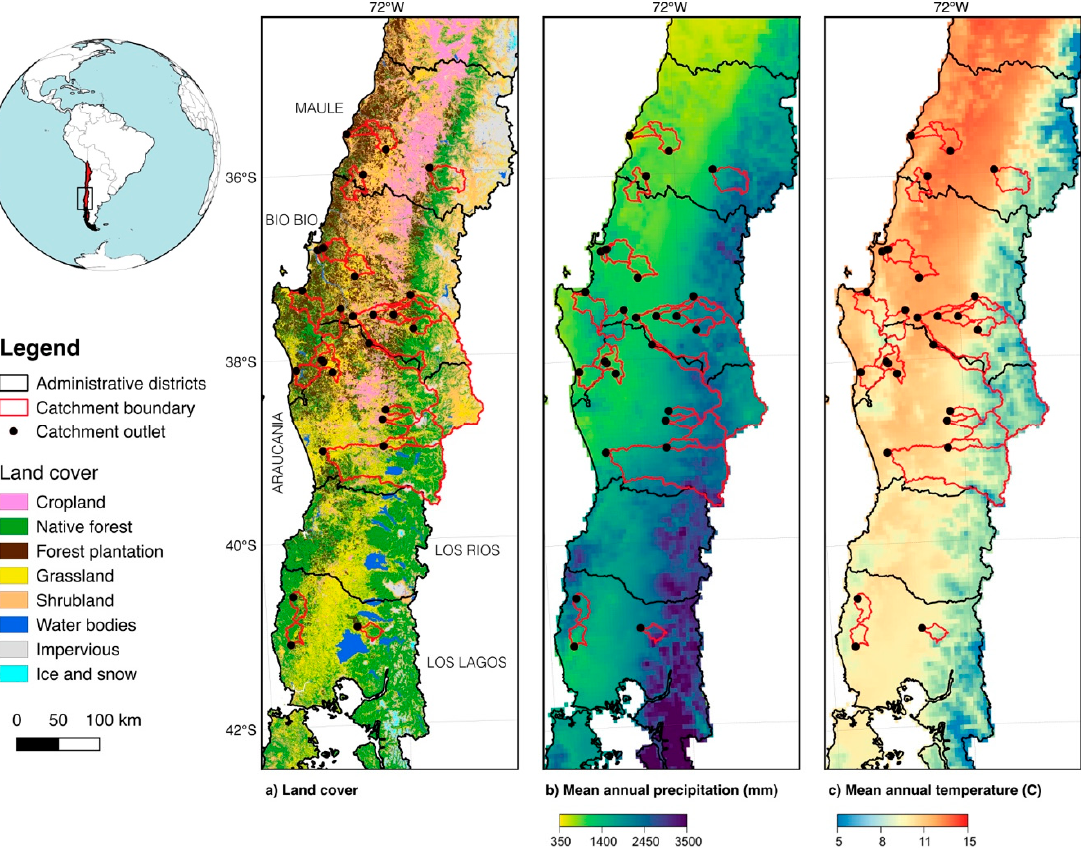
Figure 1. Twenty-five study catchments with land cover classes (panel a ), mean annual precipitation (panel b ) and mean annual temperature (panel c ).